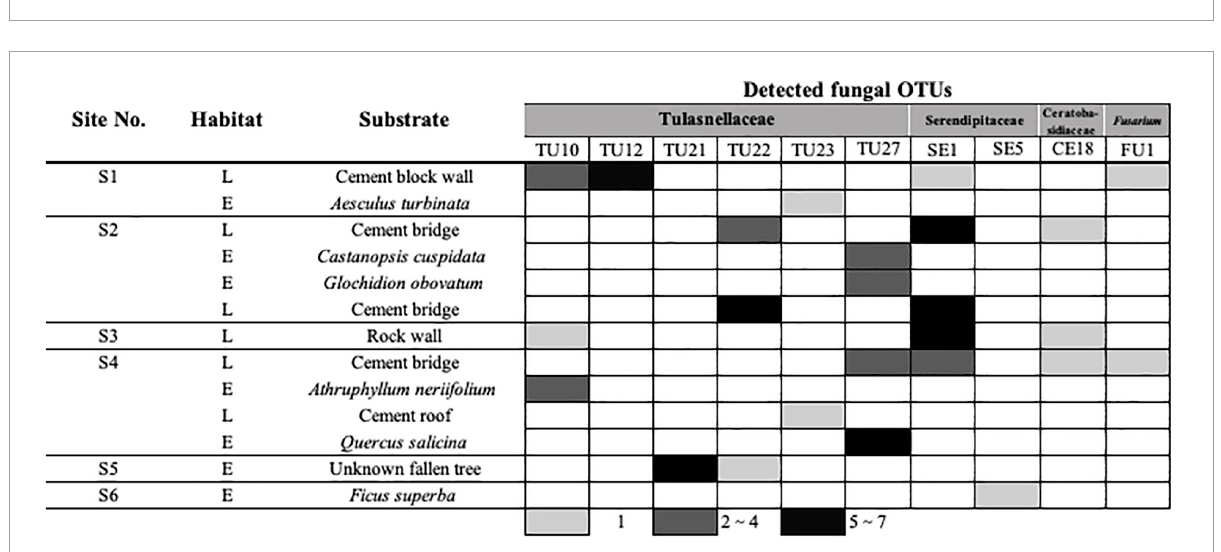
Frontiers in Ecology and